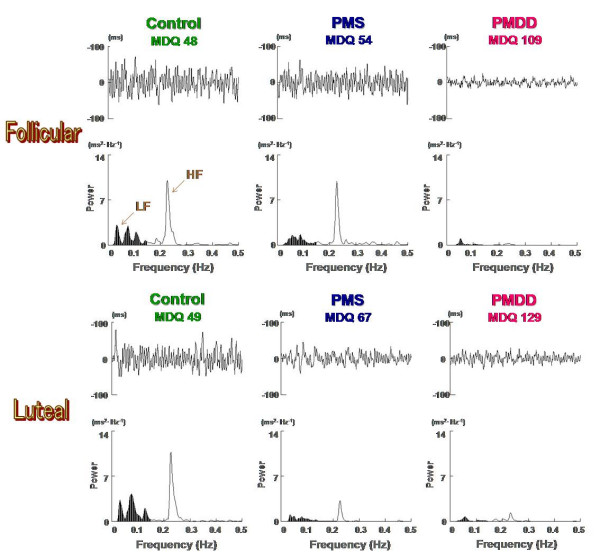
Examples of ECG R-R interval changes and the corresponding power spectra during the follicular and late luteal phase for subjects in the Control, PMS, and PMDD groups. LF: low frequency power (0.03–0.15 Hz); HF: high frequency power (0.15–0.5 Hz).